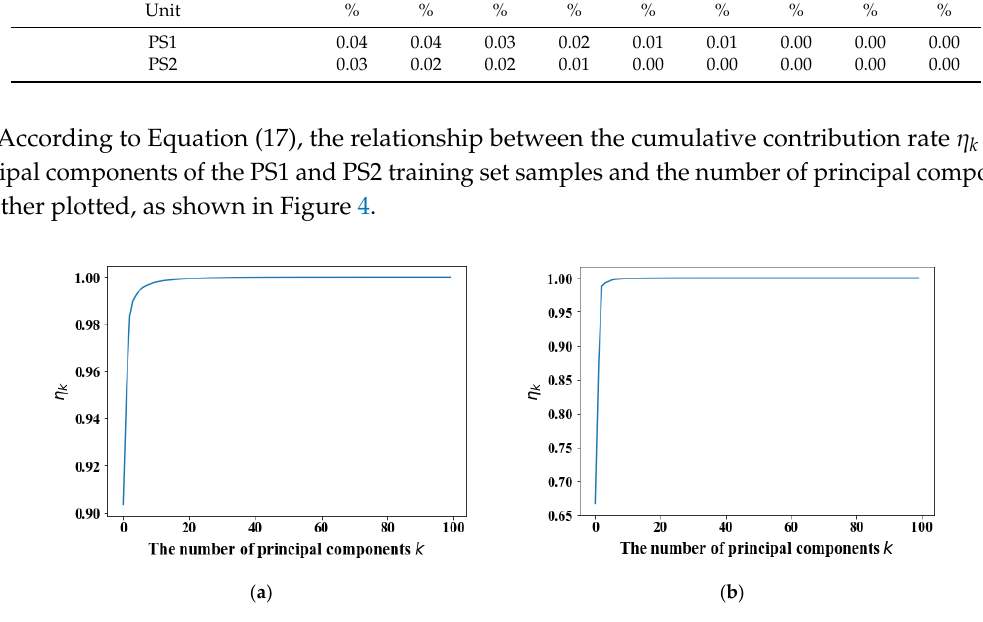
Figure 4. The cumulative contribution rate for the sample data. ( a ) The cumulative contribution rate η k of PS1 training set samples; ( b ) The cumulative contribution rate of PS2 training set samples.